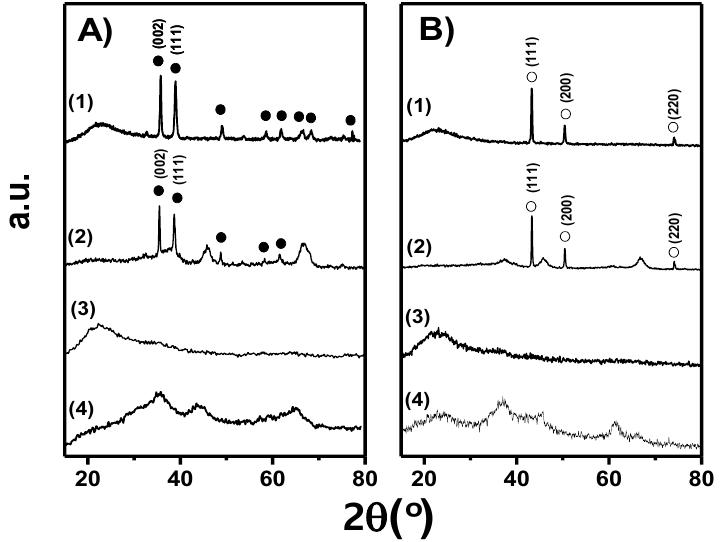
Figure 2. X-ray diffractograms of samples prepared in this work: ( A ) calcined oxide precursors and ( B ) reduced – passivated samples. (1) Cu/SiO 2 -I, (2) Cu/Al 2 O 3 -I, (3) Cu/SiO 2 -PD, (4) CuMgAl. ● CuO, ○ Cu.